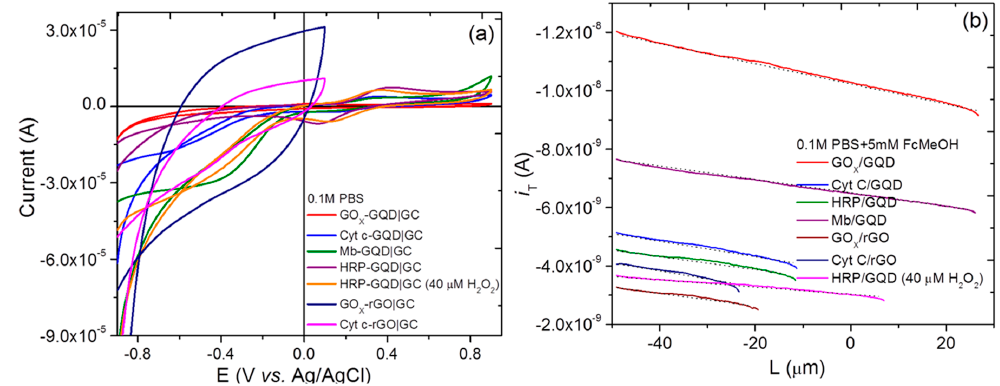
Figure 7. ( a ) Representative cyclic voltammograms (CVs) in microscale electrode (convergent diffusion) configuration; ( b ) variation of heterogeneous diffusion-controlled tip electrode current ( i T ),